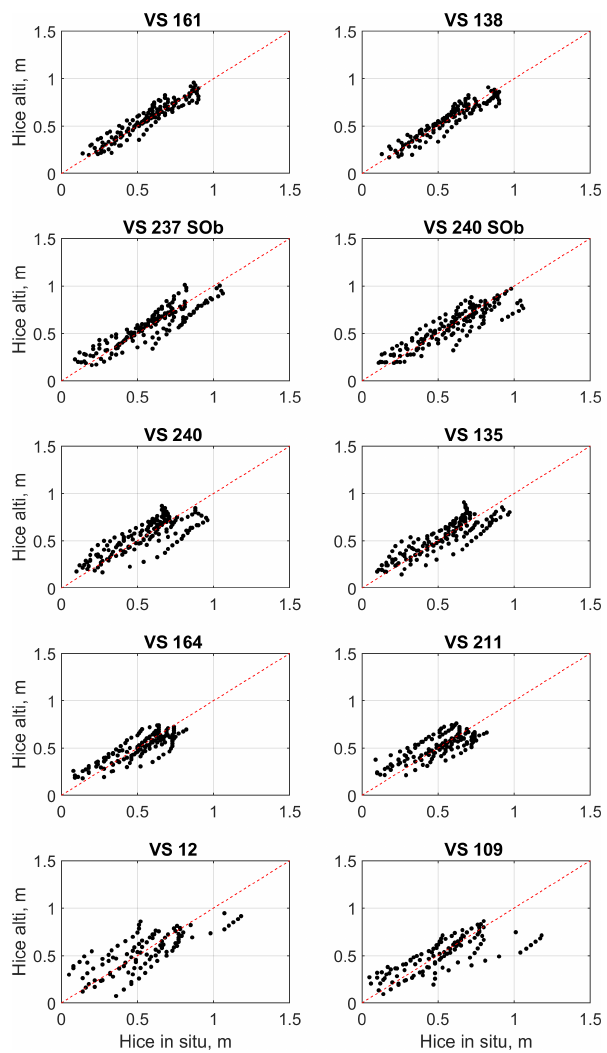
Figure 9. Ice thickness measured at gauging stations ( x axis) and retrieved from the altimetric measurements ( y axis) for the training VSs. The red dashed line corresponds to the 1 : 1 relation